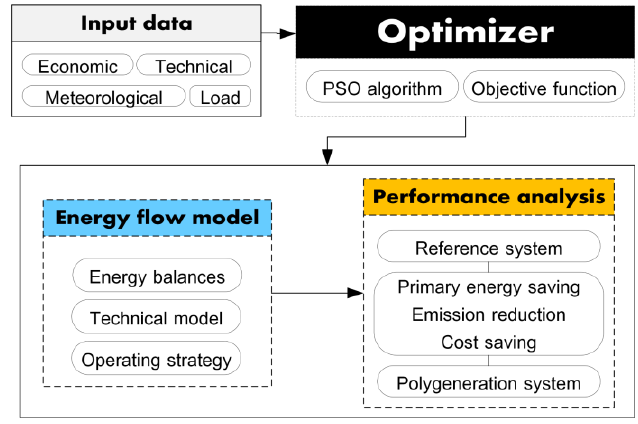
Figure 3. Flowchart of the optimization model.